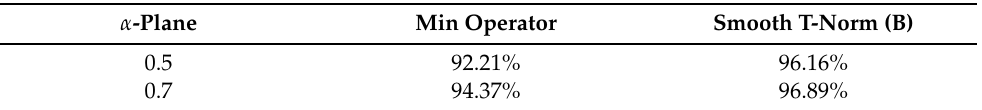
Table 2. PFOM-based comparison of the T-norm operators with additive noise to the standard deviation of the